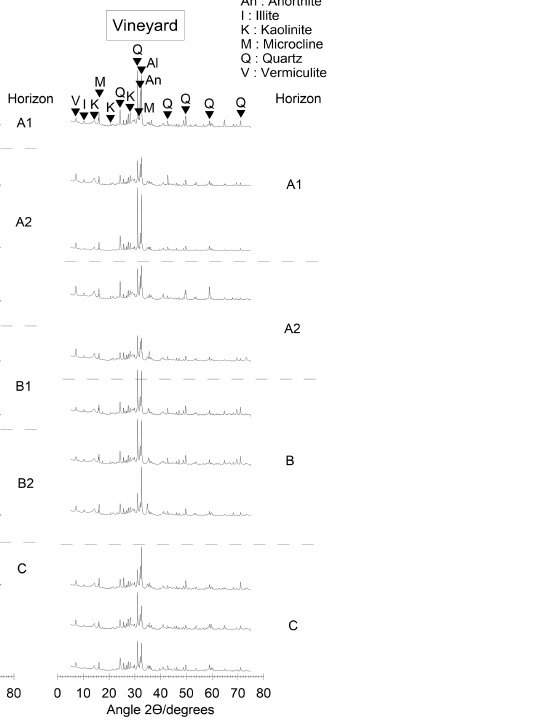
Figure B2. Forest/vineyard comparison of X-ray diffractograms as a function of soil depth. The rhombs indicate the peak considered, and the letters above are the corresponding minerals. The mineralogy was determined by X-ray diffraction on powder samples, deposited on a silicon plate, and measured using a PANalytical X’pert PRO diffractometer with a cobalt radiation source. The range of 2 θ was between 5 and 75 ◦ , with a step size of 0.033 ◦ and a measurement time of 5h 10min per sample. The forest and cultivated soil mineralogy is characteristic of a granitic bedrock with quartz, feldspar, and secondary minerals (illite and vermiculite) throughout the entire profile. The mineralogy was equivalent in both